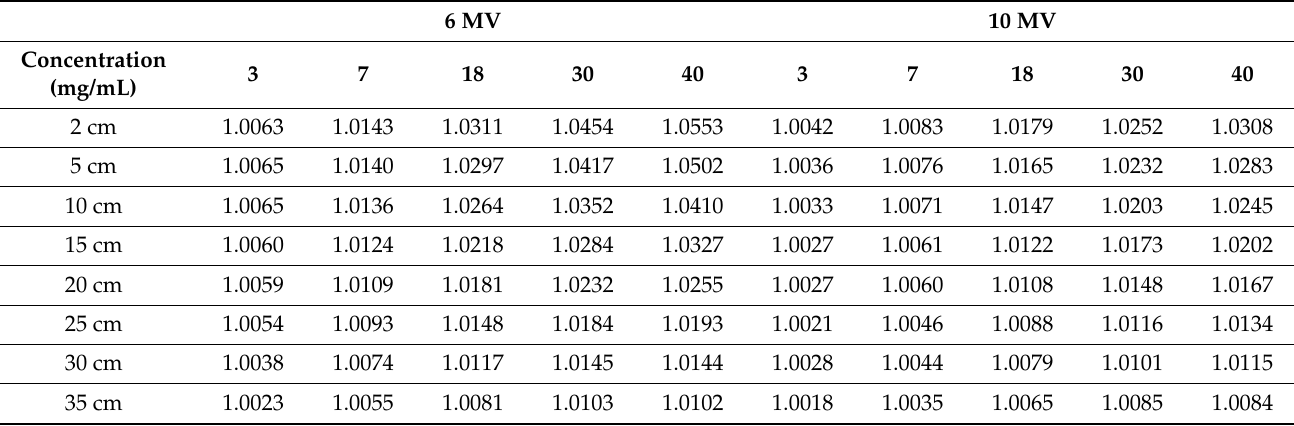
Table 2. Dependences of FFFER on the NP concentration and depth of phantom using the 6 MV and 10 MV photon